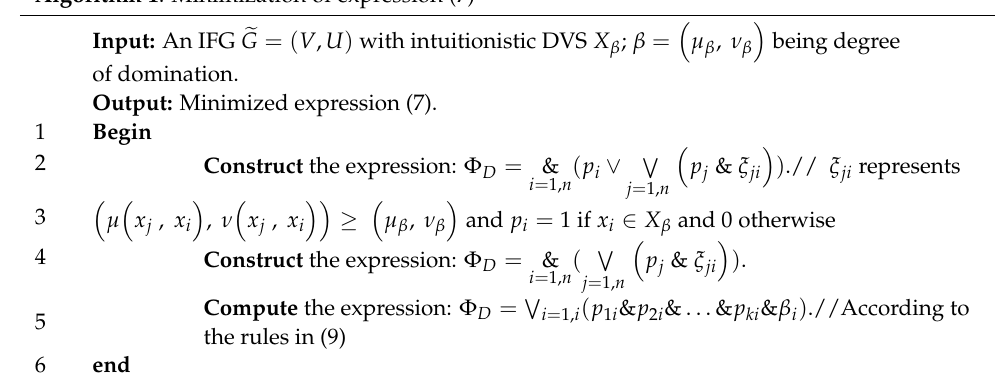
Algorithm 1 . Minimization of expression